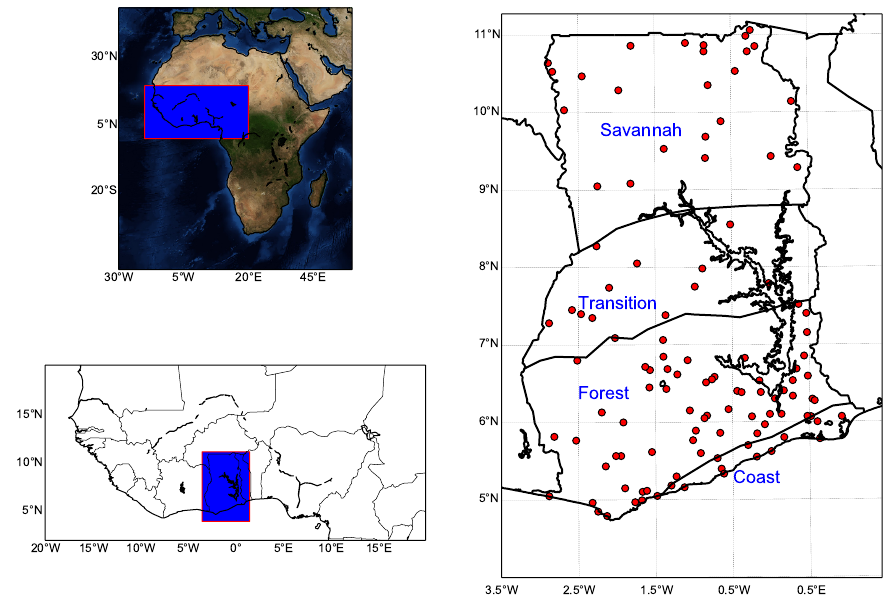
Figure 1. The map showing location of Ghana, its ecological zones, and the GMet rainfall measurement locations across the